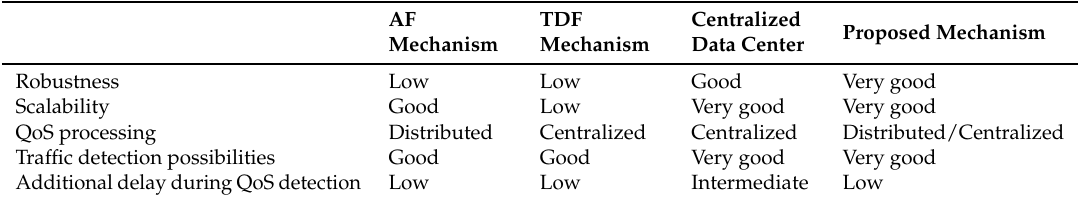
Table 1. Comparison of QoS traffic detection strategies. AF, Application Function; TDF, Traffic Detection Function.